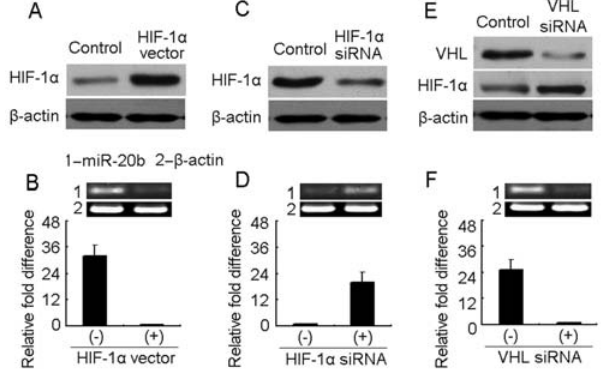
Figure 3. miR-20b is downregulated by HIF-1 a . (A and B) HIF-1 a decreased miR-20b expression in normoxic H22 cells. HIF-1 a vector or mock vector was transfected into normoxic H22 cells. 72 hr later, the cells were used for HIF-1 a analysis by Western blot (A) and miR-20b analysis by RT-PCR and real time RT-PCR (B). (C and D) HIF-1 a siRNA was transfected into hypoxic H22 cells. 72 hr later, the cells were used for HIF-1 a analysis by Western blot (C) and miR-20b analysis by RT-PCR and real time RT-PCR (D). (E and F) VHL siRNA was transfected into normoxic H22 cells. 72 hr later, the cells were used for VHL and HIF-1 a analysis by Western blot (E) and miR-20b analysis by RT-PCR and real time RT-PCR (F).